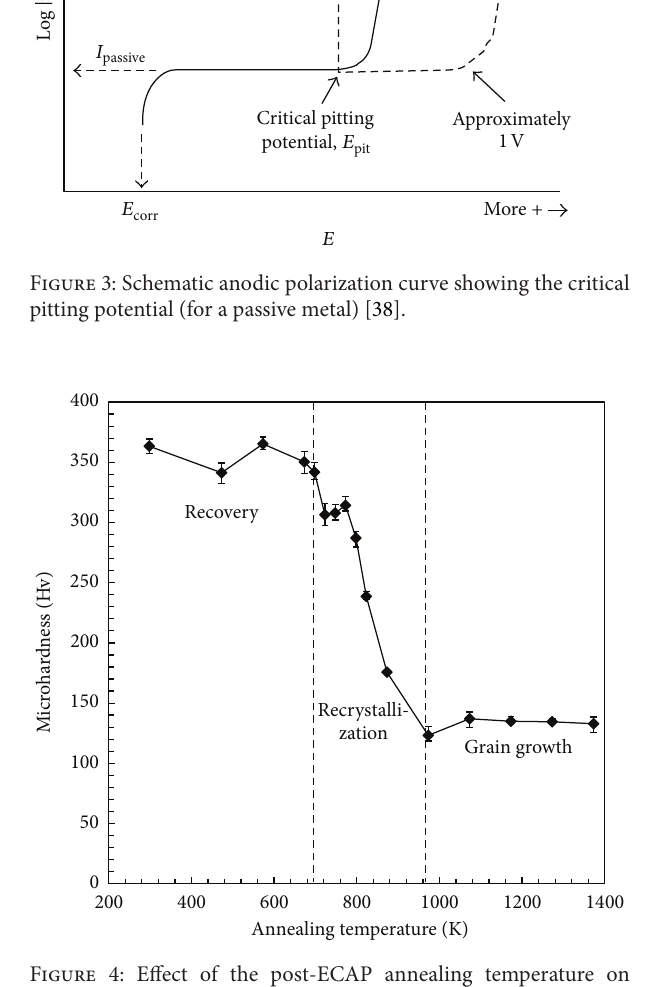
Figure 4: Effect of the post-ECAP annealing temperature on Vickers